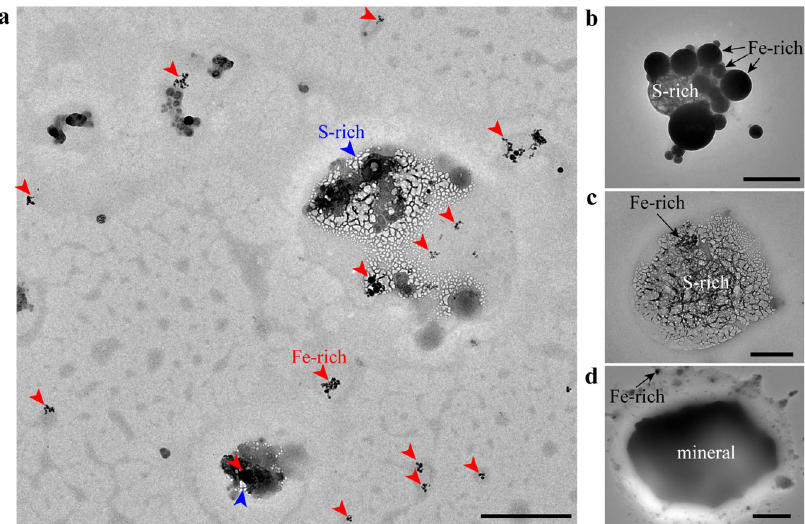
Fig. 3 Morphology and mixing state of various Fe-containing particles collected under different conditions. a Bare nanosized Fe-rich particles and internally mixed Fe-rich particles with secondary acidic aerosols (S-rich) collected under the haze condition. b Aggregation of nanosized Fe-rich particles associated with S-rich under the haze condition. c Nanosized Fe-rich particle internally mixed with S-rich collected under the non-haze condition. d Mineral dust particle-containing Fe collected under the dust condition. The scale bars are 500 nm in panels a – c and 2 μ m in panel d .